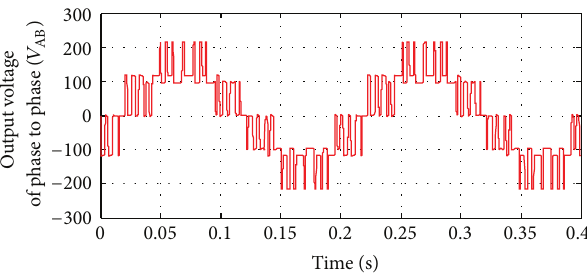
Figure 16: Line to line (A-B) voltage of inverter without implement- ing filters.